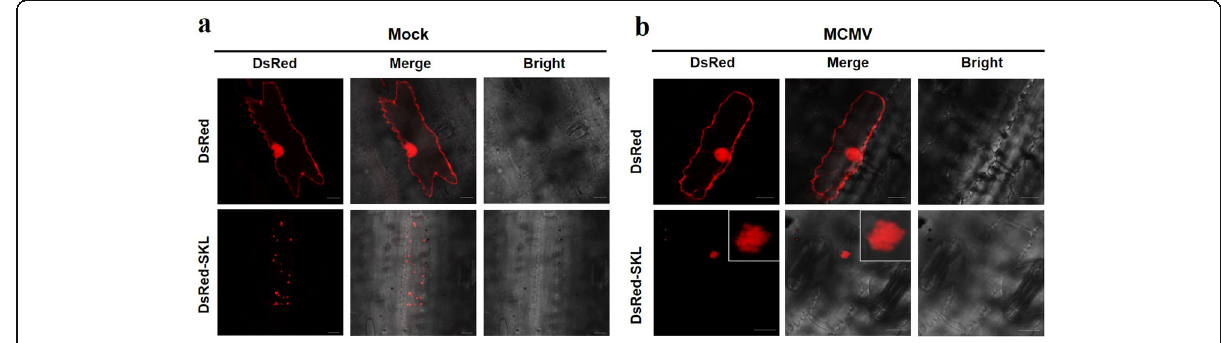
Fig. 2 Peroxisomes relocalize to form aggregated bodies in maize chlorotic mottle virus (MCMV)-infected cells. a , b Particles carrying each of the two plasmids expressing DsRed or DsRed-SKL were bombarded into mock- ( a ) and MCMV-inoculated ( b ) maize (B73) leaves. The bombarded leaves were visualized at 36 h post-bombardment (hpb) by confocal microscopy. Bars, 10 μ